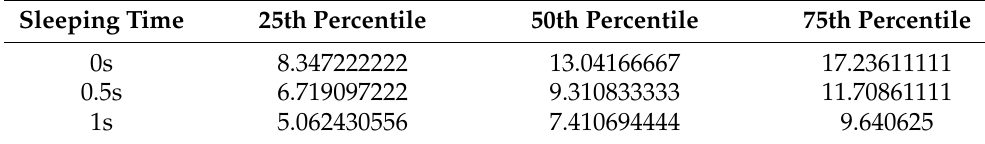
Figure 7. Representation of R POST , varying the number of sending ROADM devices N and the sleeping time. Table 1. 25th percentile, median and 75th percentile of results for the first